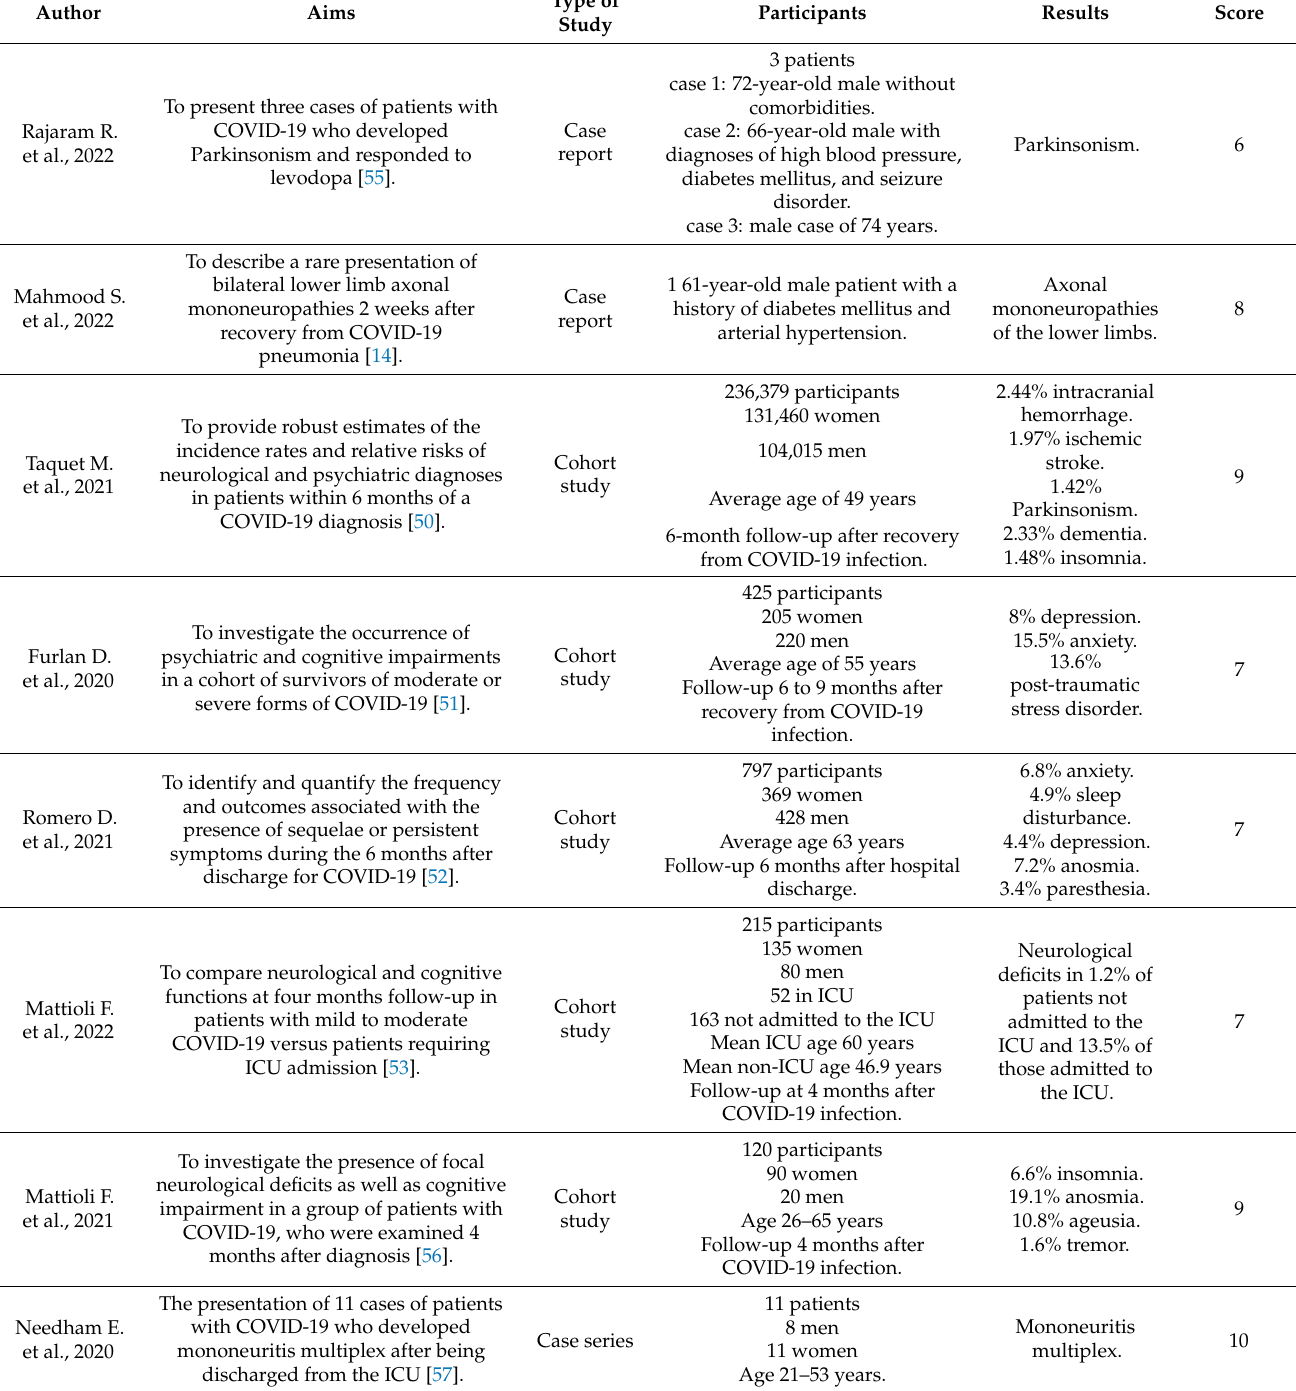
Table 4. Summary of literature mentioning neurological and psychiatric